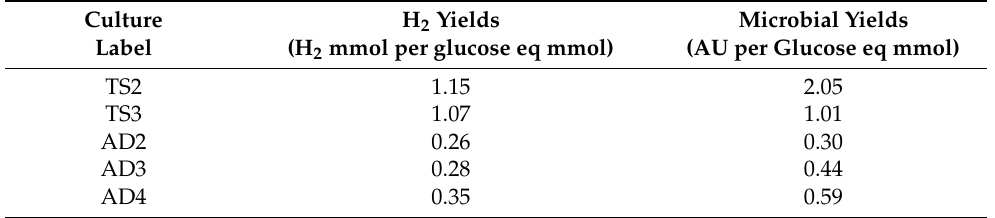
Table 3. Hydrogen and microbial yields.